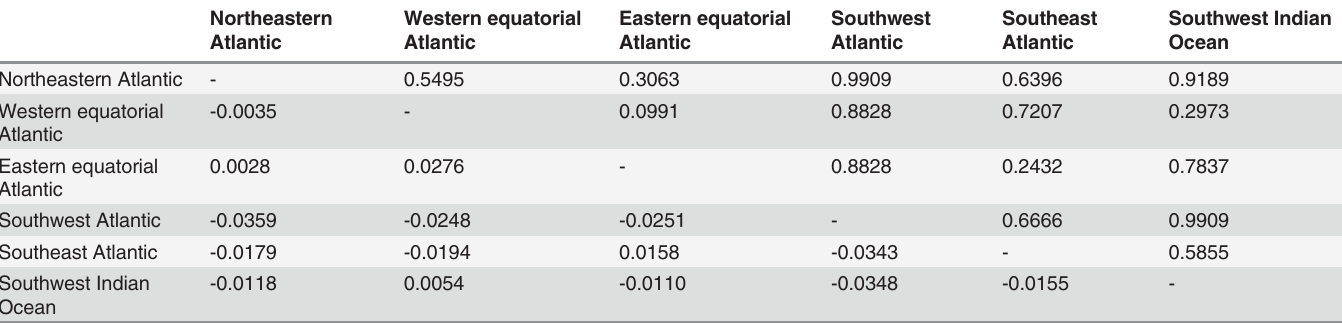
Table 3. Differentiation ( F ST ) between pairs of sampled regions in the Atlantic and Indian Oceans.